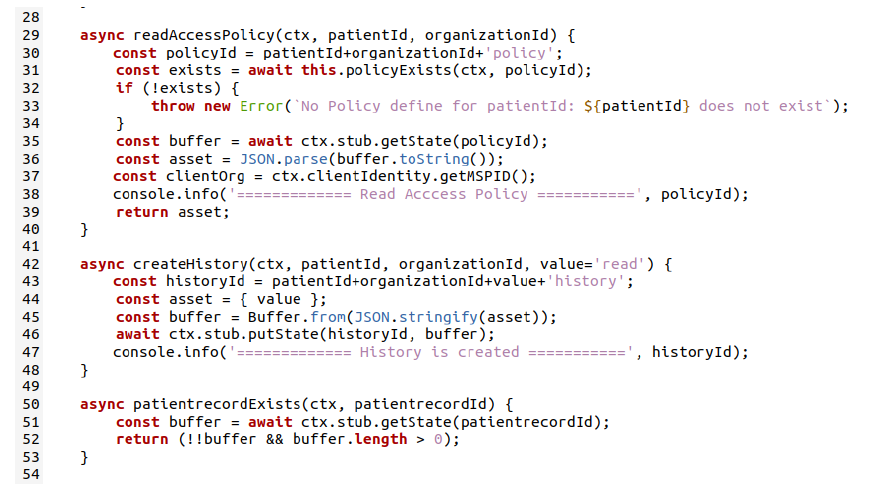
Figure 12. Smart-contract code using Node.js.